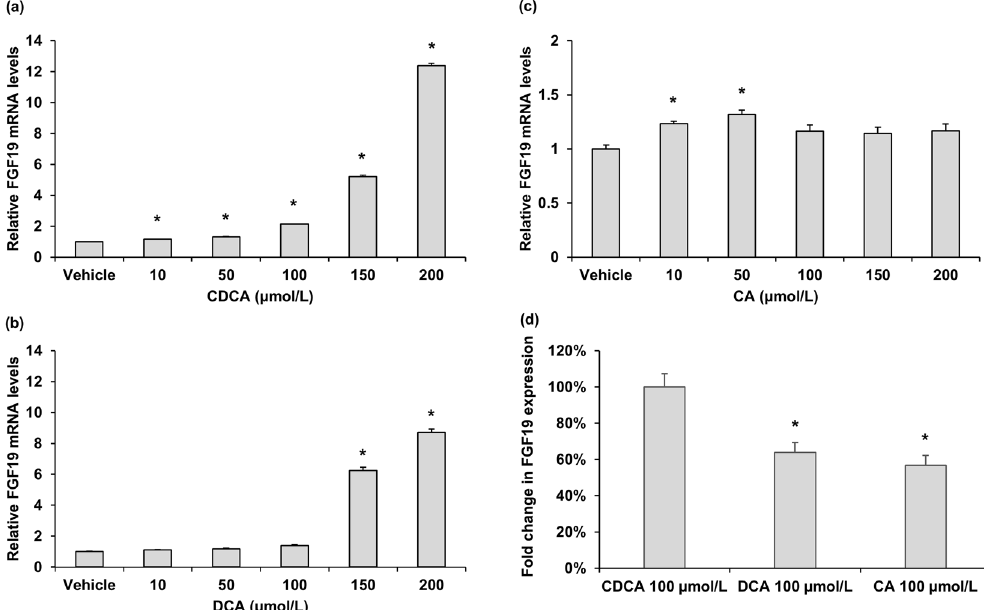
Figure 6. Effect of BAs treatment on FGF19 mRNA levels in LS174T cells. Effect of different concentration of CDCA ( a ), DCA ( b ) and CA ( c ) treatment on FGF19 mRNA levels. Data are mean ± SEM, n = 4. * P < 0.05, compared vs. vehicle. ( d ) Relative potencies of 100 μ mol/L CDCA, DCA and CA at inducing FGF19 mRNA expression in LS174T cells. Data are mean percentages ± SEM, n = 4. * P < 0.05, compared vs. CDCA 100 μ mol/L.